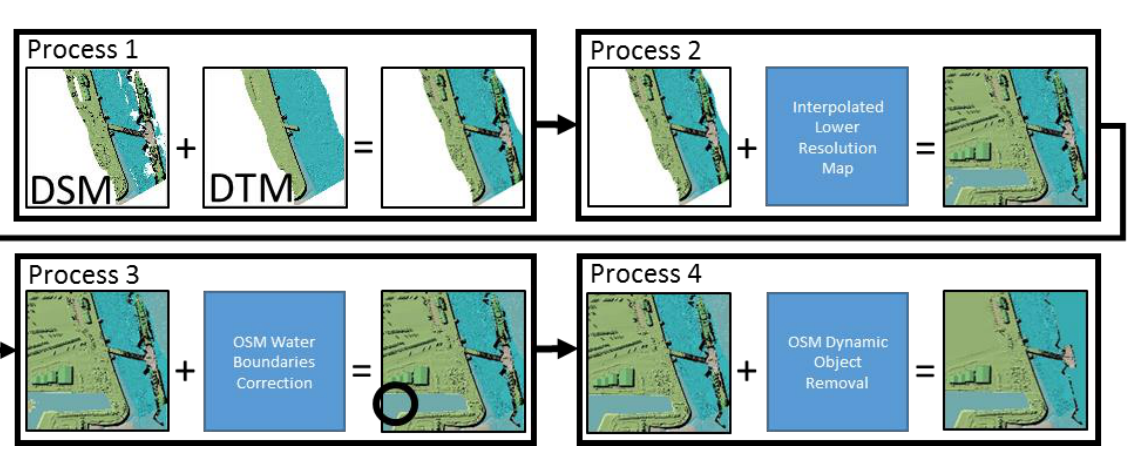
Figure 7. Hybrid map combination for improved map